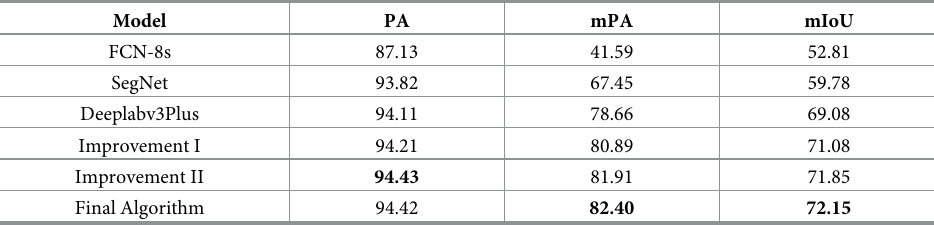
Table 2. Overall segmentation results of Cityscapes (unit: